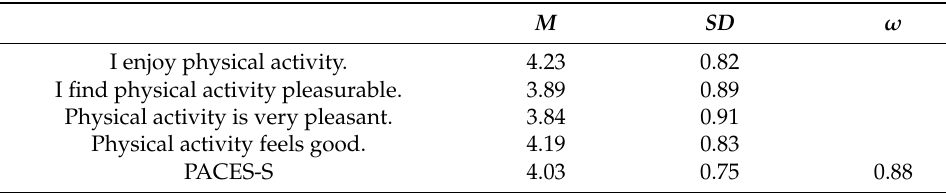
Table 4. Descriptive statistics of Study